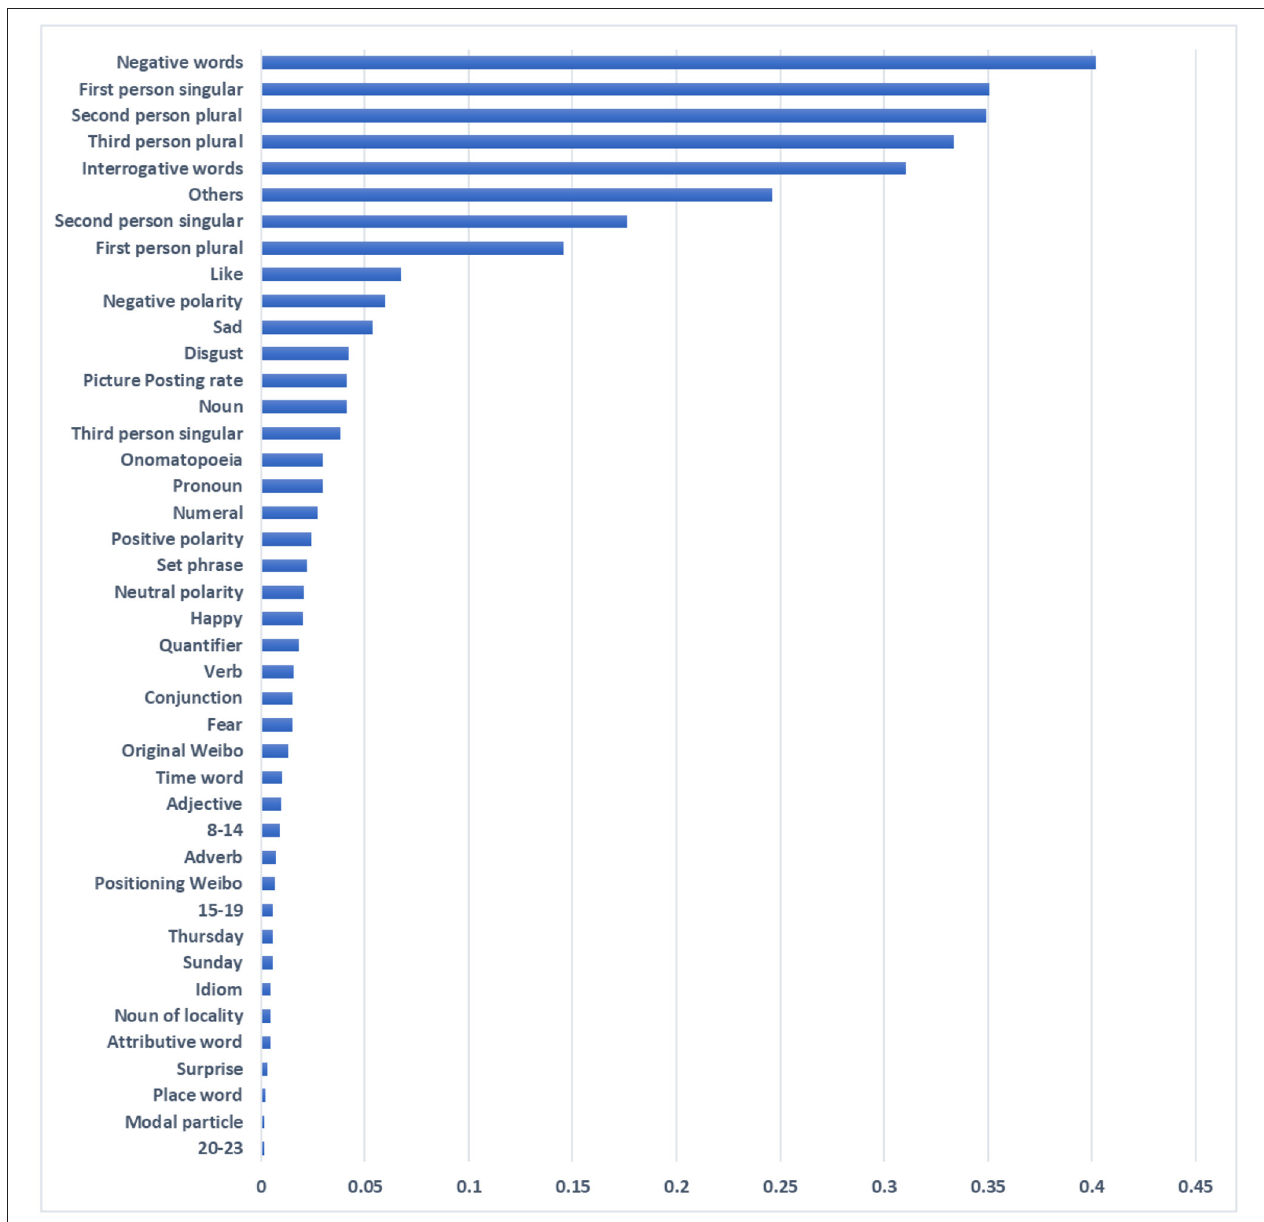
FIGURE 3 | Relative importance of